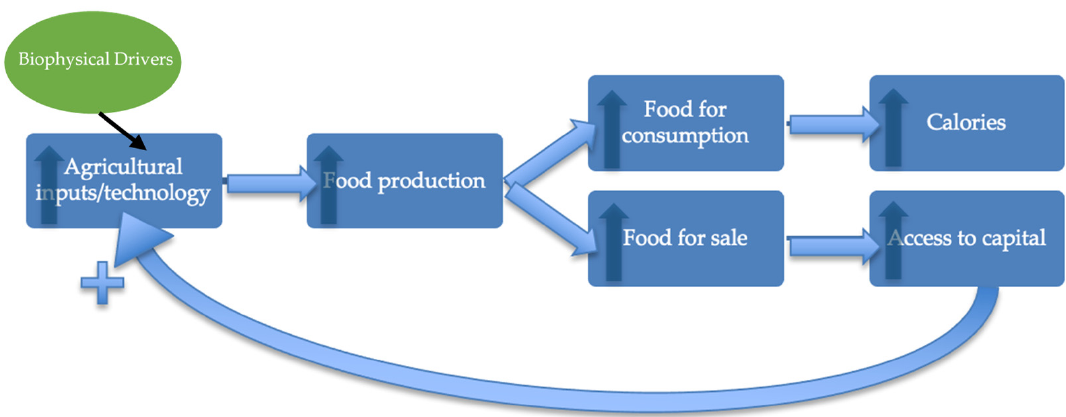
Figure 1. The classical agricultural development paradigm focuses on increasing food production for the purpose of generating calories and income [26,27]. This process is relatively linear, neglecting those feedbacks or responses relating to culture or context. The arrows demonstrate feedbacks within this linear model, whereby an increase in inputs results in an increase in food production, and eventually in an increase in calories and capital, which can further be invested in increased inputs/technology.